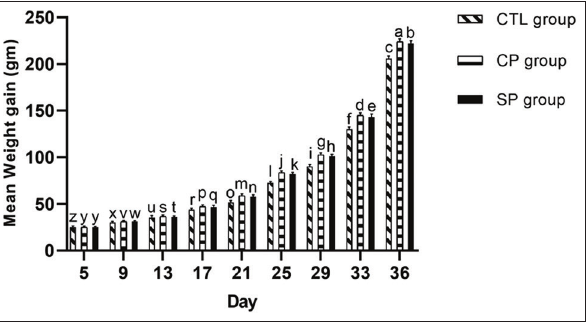
Figure-1: Weight gain (g) of broilers fed basal diets supplemented with antibiotic (CTL group), commercial probiotic Protexin ® (CP group), and study probiotic mixture (SP group). Values are mean body weight gain at every 4 th days’ interval. Within each day, different letters indicate significant difference in values at p < 0.05 (ANOVA, Duncan’s